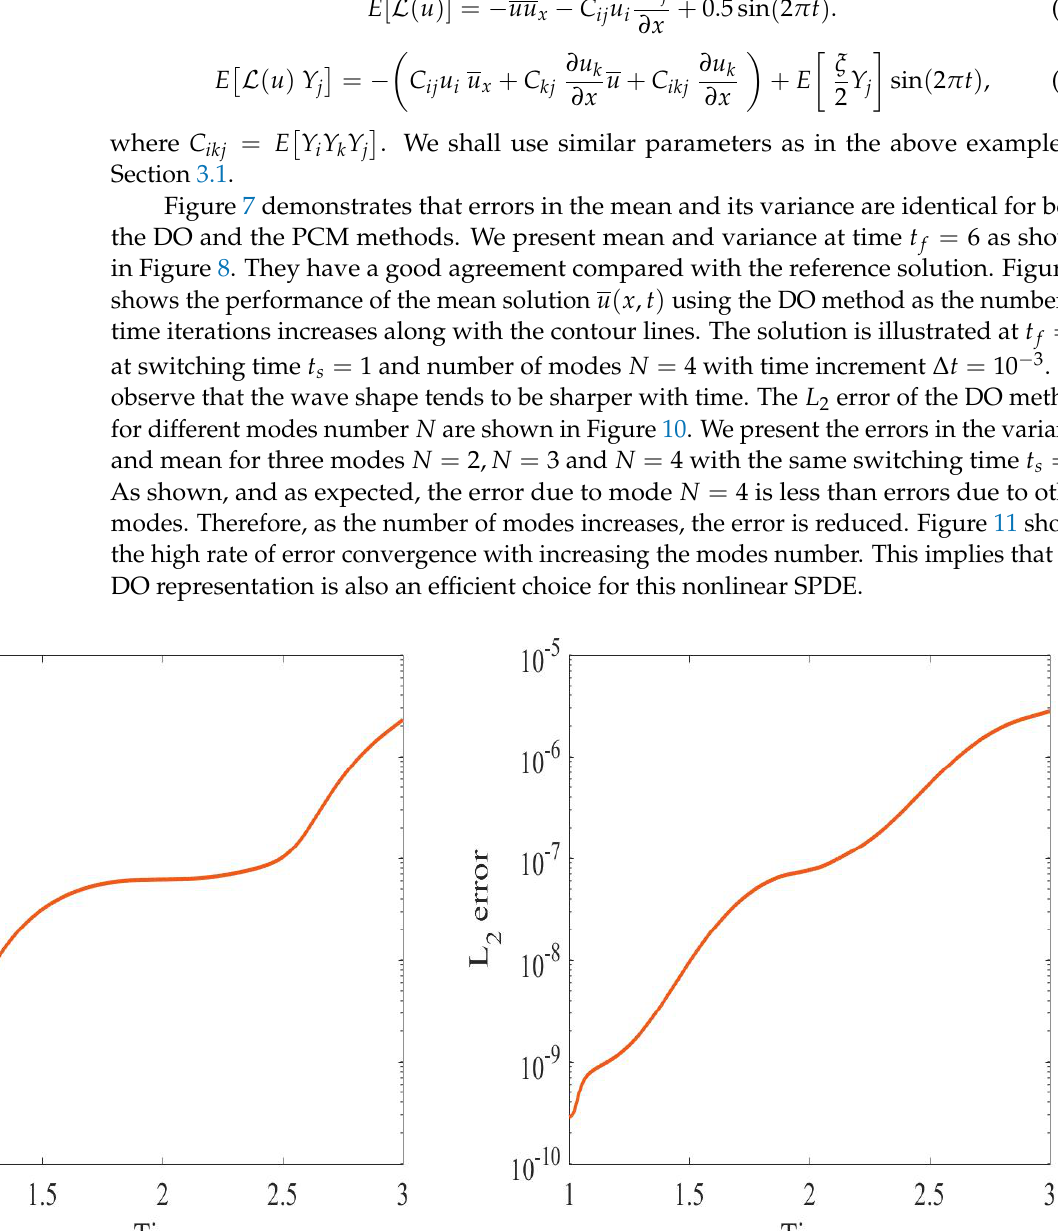
Figure 8. The mean of the solution ( left ) and its variance ( right ) for the inviscid Burgers’ equation at   =  , switching time   =  with modes  =  . The reference solution is the PCM solution.